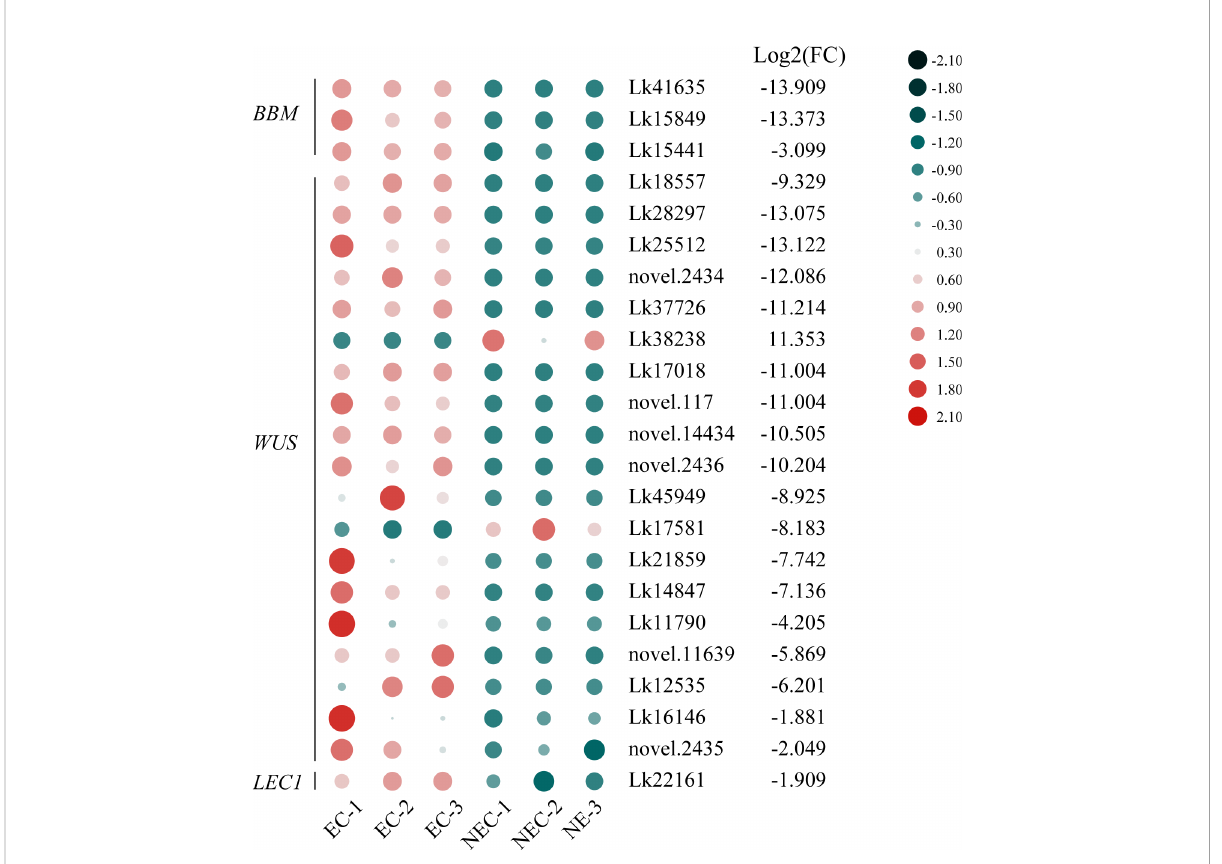
FIGURE 8 Expression patterns of totipotency-related transcription factor (TF) genes between EC and NEC in L. kaempferi . Gene expression levels were calculated based on FPKM values. Red and green dots represent upregulation and downregulation of gene expression,